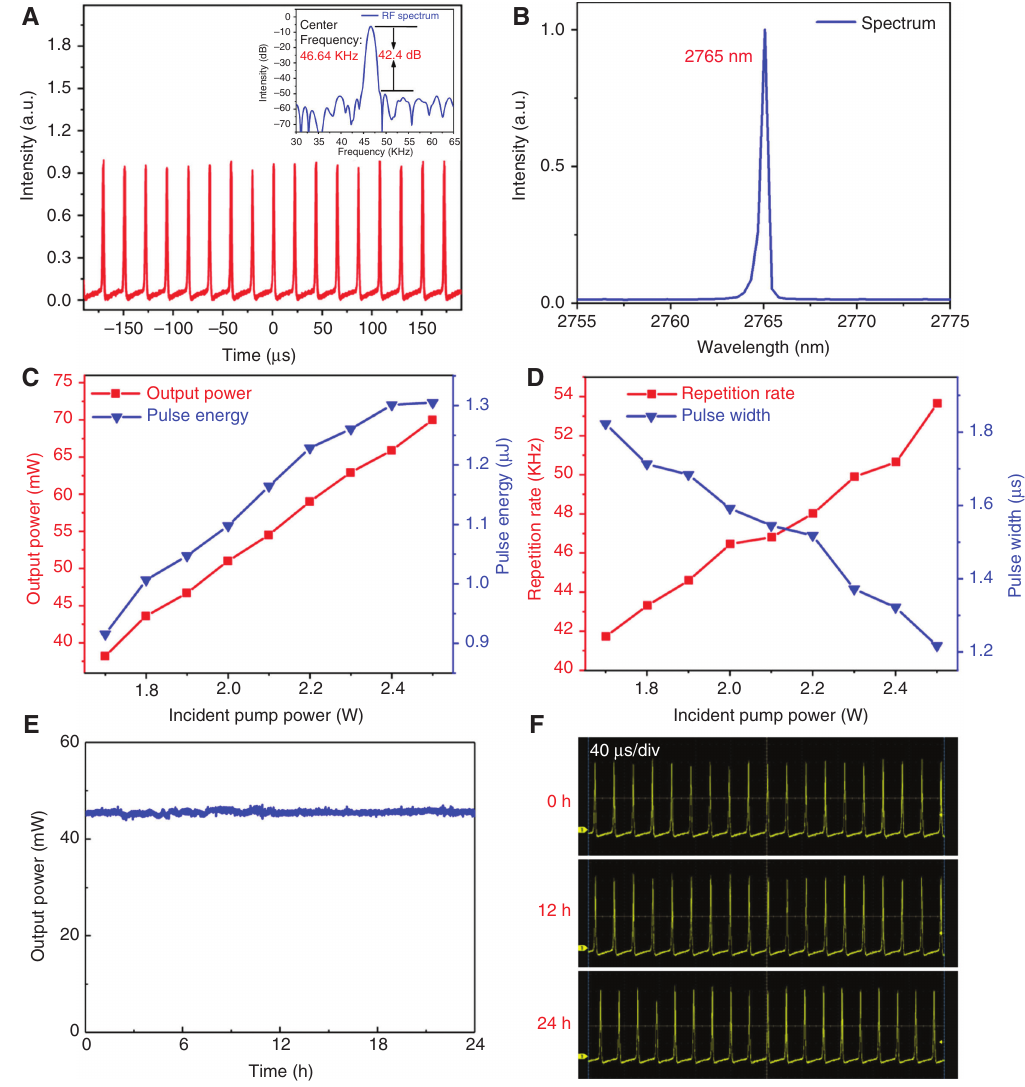
Figure 5: Q-switching results of 2.8 μ m Er:ZBLAN fiber laser using InSe film as SA. (A) Q-switching pulse train; inset: RF spectrum. (B) Optical spectrum of the Q-switched laser. (C) Average output power and pulse energy versus the incident pump power. (D) Repetition rate and pulse width versus the incident pump power. (E) Output power stability in 24 h. (F) Pulse trains recorded at 0 h, 12th h, and 24th